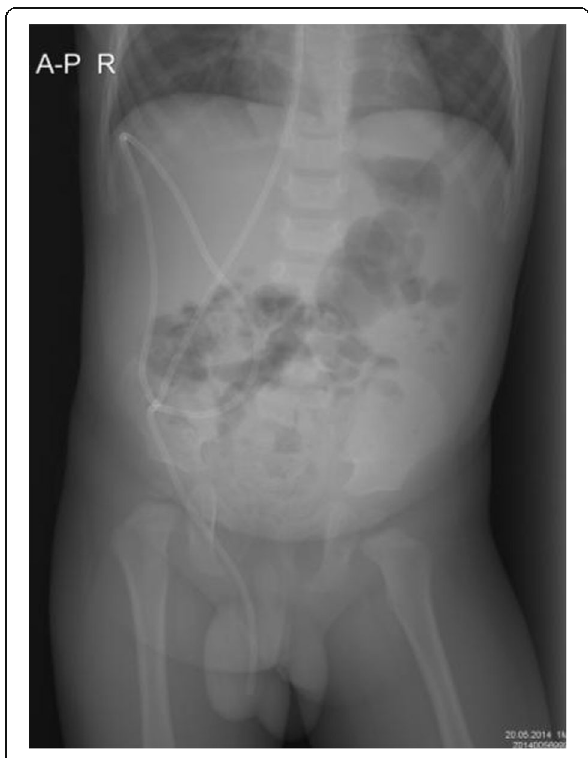
Fig. 1 AP radiograph of the chest and abdomen showed shunt tube in the abdomen which was twisted and kinked in its mid portion and its distal end in the right scrotum